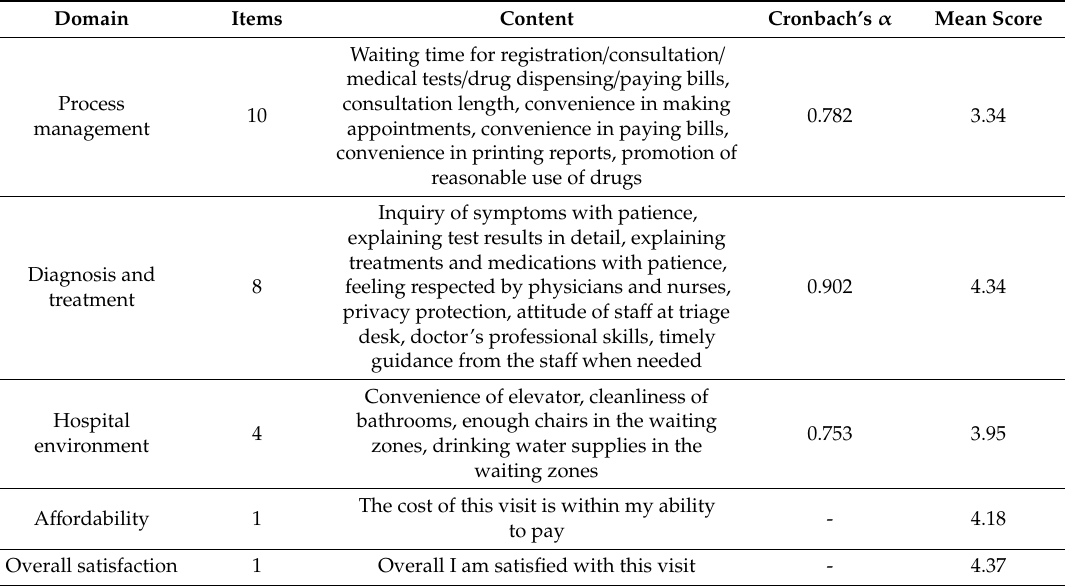
Table 1. Content of the four domains and overall satisfaction, internal consistency, and mean domain